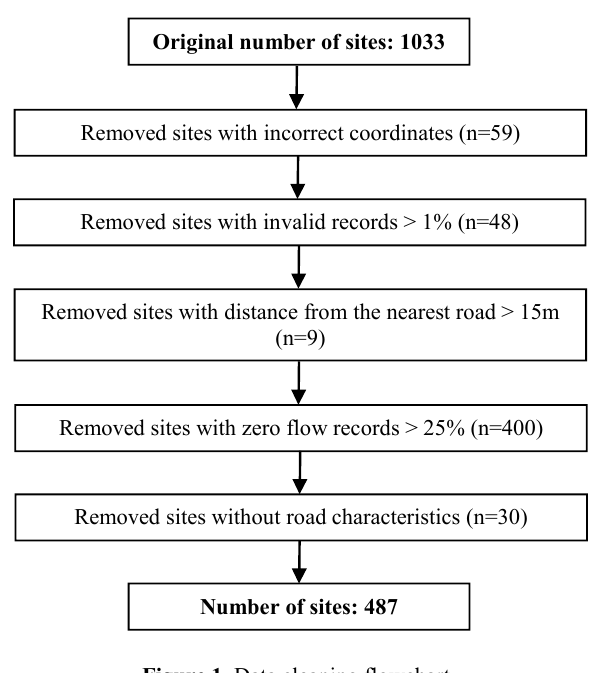
Figure 1 . Data cleaning flowchart.